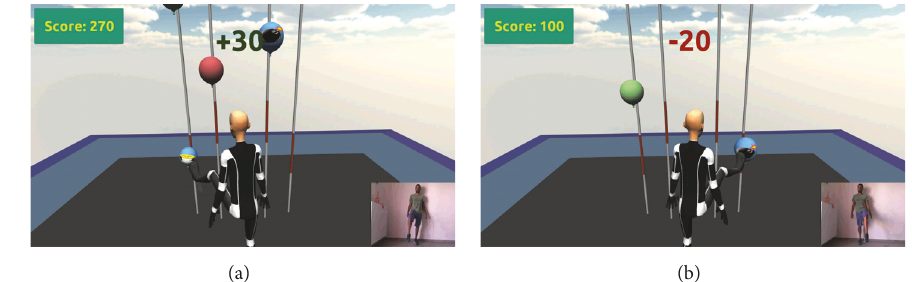
Figure 7: At higher game levels in the Balloon Goon Game, balloons fall faster and more frequently and carry higher reward (as in screenshot a) or penalty (as in screenshot